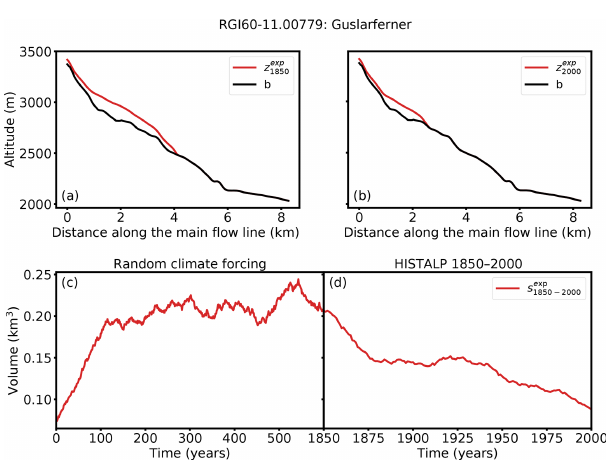
Figure 1. Illustration of the generation of the synthetic experiment with the example of Guslarferner (Ötztal, Austria). Glacier thick- ness along the main flow line at (a) t 0 = 1850 and (b) t e = 2000 is shown. The black line indicates the bed rock and the red line the ice surface of the synthetic experiment. (c) Generation of s exp is the state at t = 600 (the end of the trajectory), and (d) the volume of the glacier states s exp t from 1850 to 2000. Note that the synthetic year 2000 glacier does not necessarily correspond to the “true” year 2000